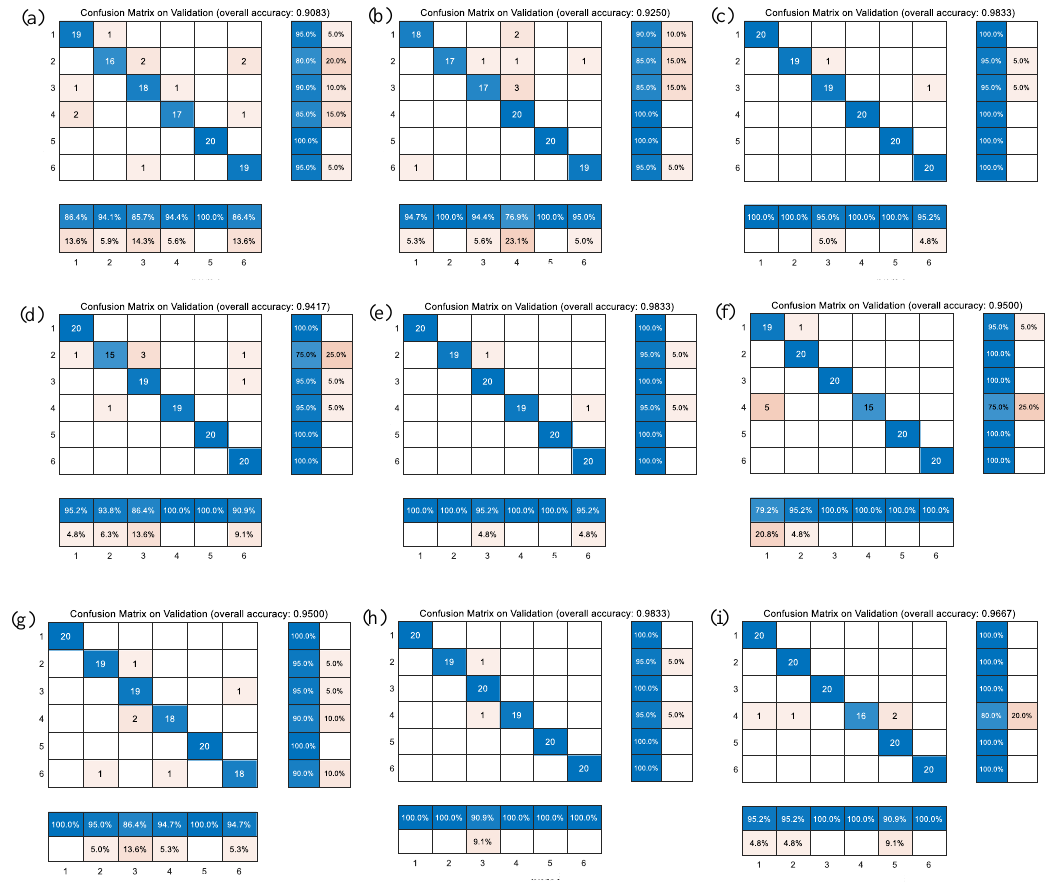
Figure 9. Comparison of confusion matrix results of nine categories of transfer learning models. ( a )